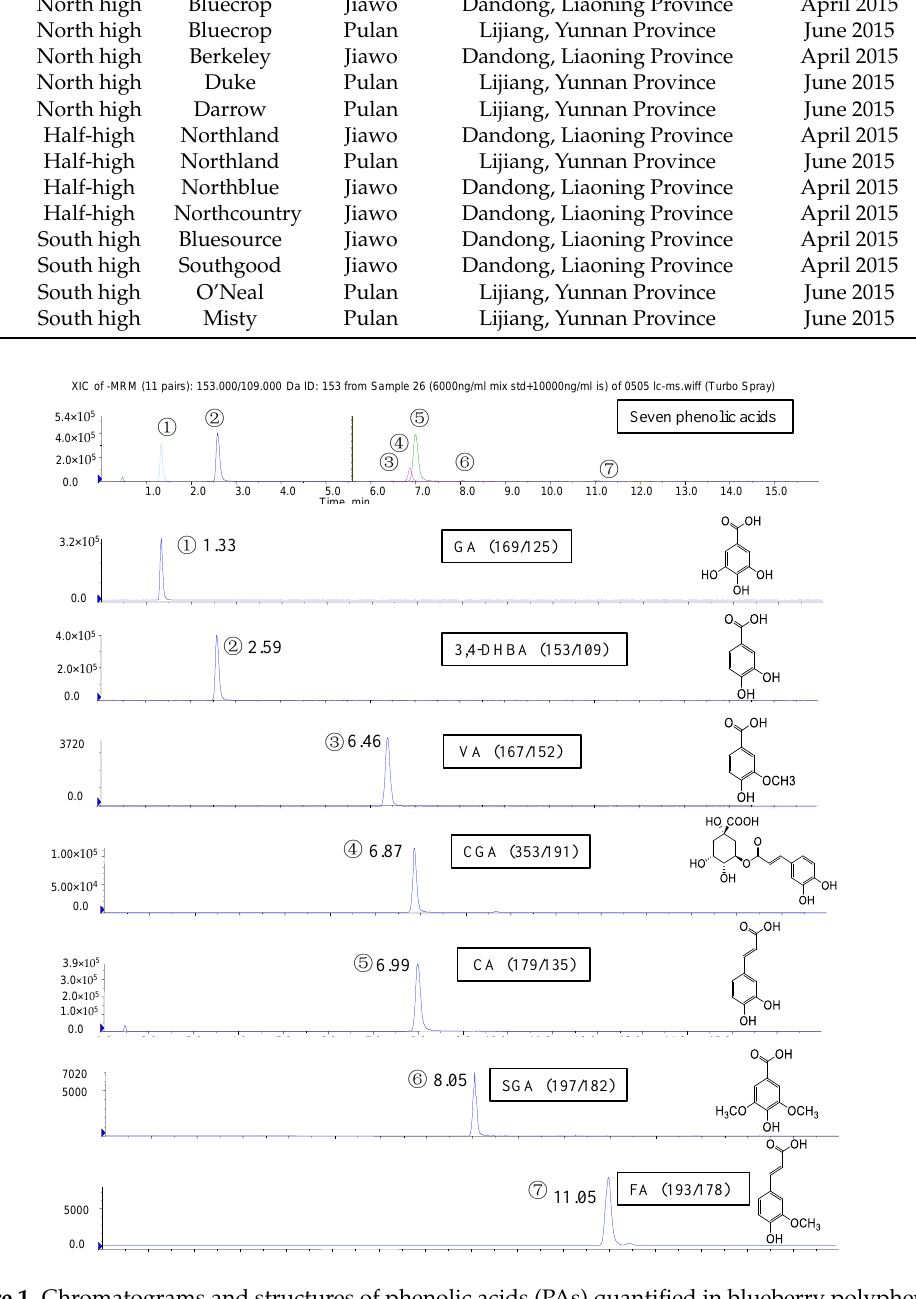
Figure 1. Chromatograms and structures of phenolic acids (PAs) quantified in blueberry polyphenol fractions with high-performance liquid chromatography coupled with electrospray ionization tandem mass spectrometry (HPLC/MS 2 ). Please provide a clearer picture of all the